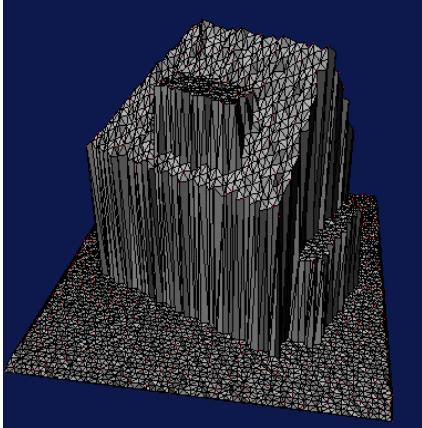
Fig. 5. TIN of the points of Figure 4.